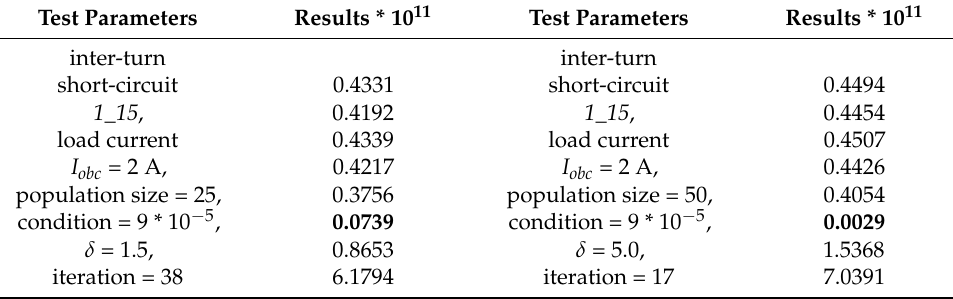
Table 2. Example results of H 1 matrix tests for rotational speed n l